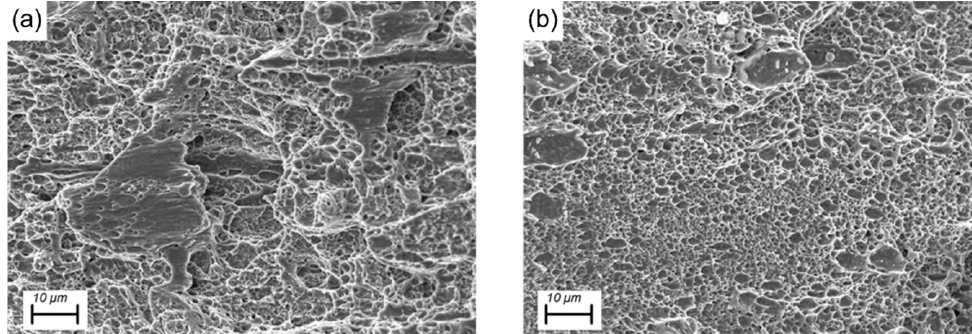
Figure 8. Pictures from scanning electron microscopy of the fracture surfaces for load cases 1/ − 0.5 ( a ) and 1/0 to 1/ − 0.5 ( b ). and 1/0 to 1/ − 0.5 ( b